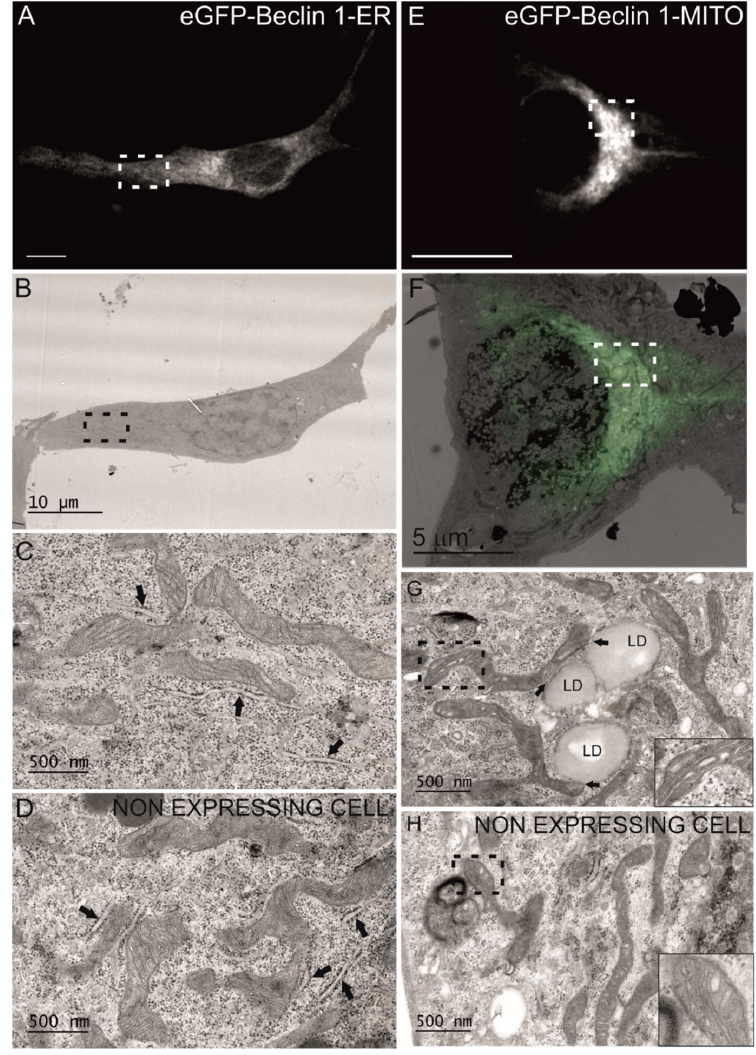
Figure 3. Electron microscopy analysis of MEF-WT cells expressing eGFP-Beclin 1-ER or eGFP-Beclin 1-MITO. The cells were starved for 1 h in amino-acid-free medium before fixation. ( A – D ) MEF-WT cells transfected with eGFP-Beclin 1-ER. ( A ) Confocal image of a cell expressing eGFP-Beclin 1-ER. Scale bar, 10 μ m. ( B ) Electron micrograph of the same cell as in panel A. ( C ) Higher magnification of the boxed area in panel B, showing normal morphology of rough ER (arrows). ( D ) Electron micrograph of a non-expressing cell from the same sample, showing the morphology of rough ER (arrows). ( E – H ) MEF-WT cells transfected with eGFP-Beclin 1-MITO. ( E ) Confocal image of a MEF-WT cell expressing eGFP-Beclin 1-MITO. Scale bar, 10 μ m. ( F ) Electron micrograph of the same cell as in panel E. ( G ) Higher magnification of the boxed area in panel F, showing mitochondria and contact sites between lipid droplets (LD) and mitochondria (arrows). ( H ) Electron micrograph of a non-expressing cell from the same sample, showing the morphology of mitochondria. Inserts in panels G and H show mitochondrial cristae at higher